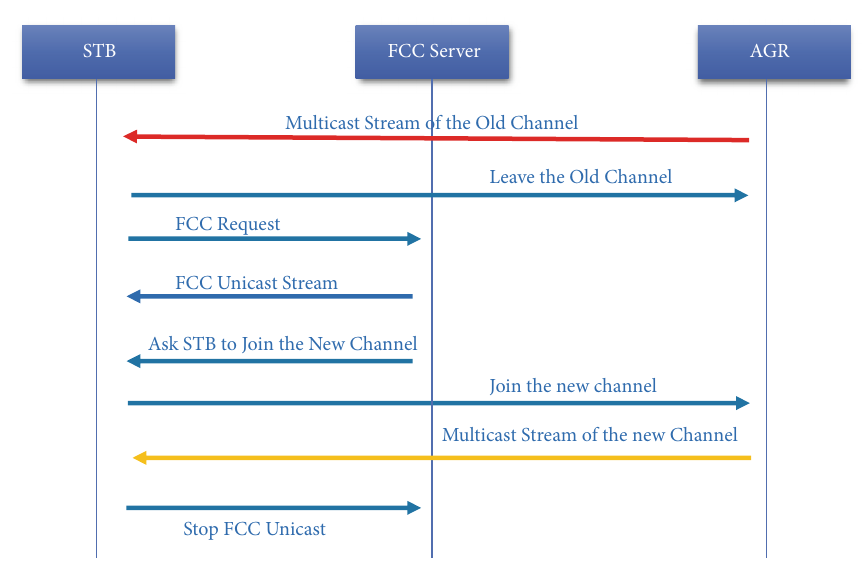
Figure 3: FCC work